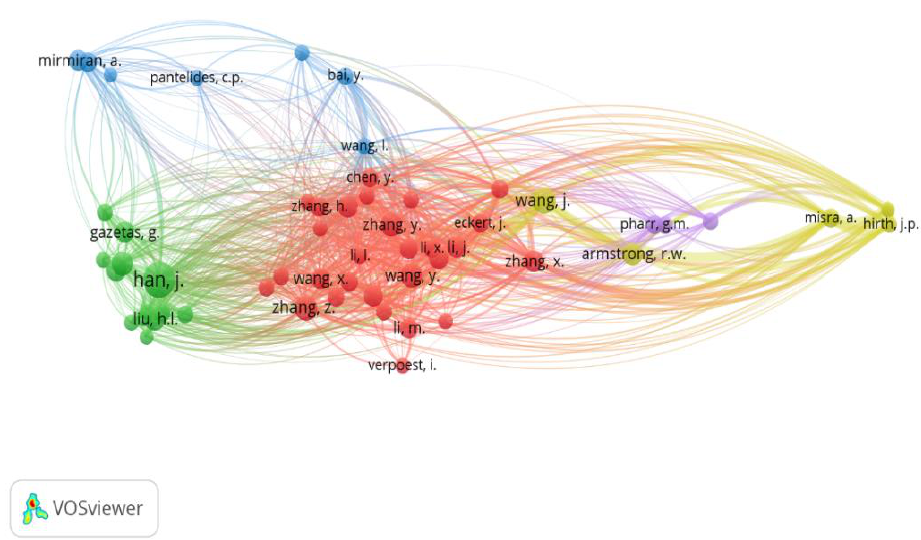
Figure 7. Author co-citations and their connections.